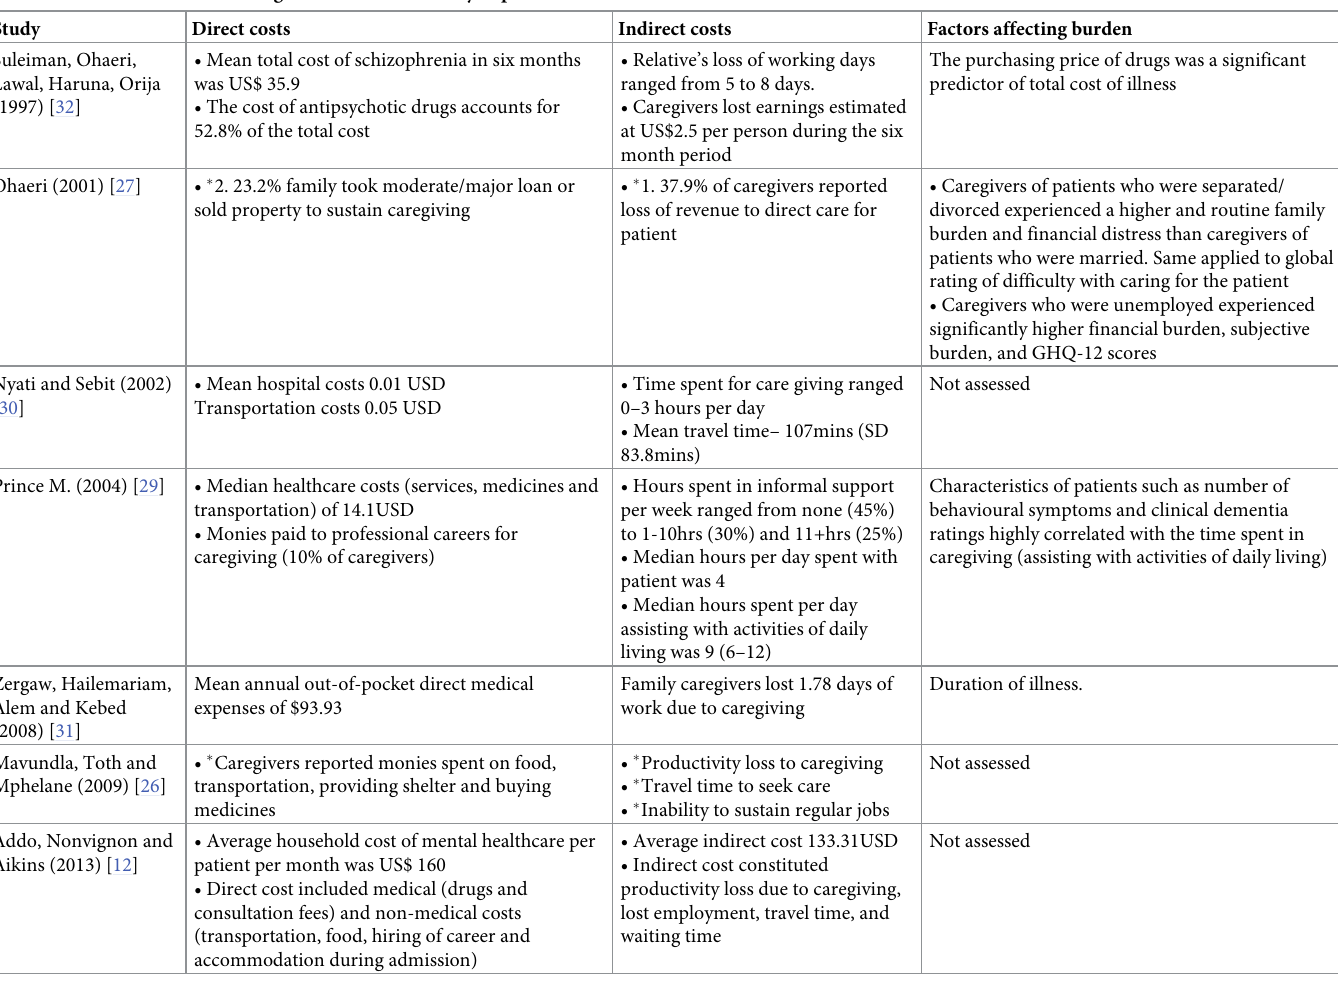
Table 3. Economic burden of caregivers of severe mentally ill